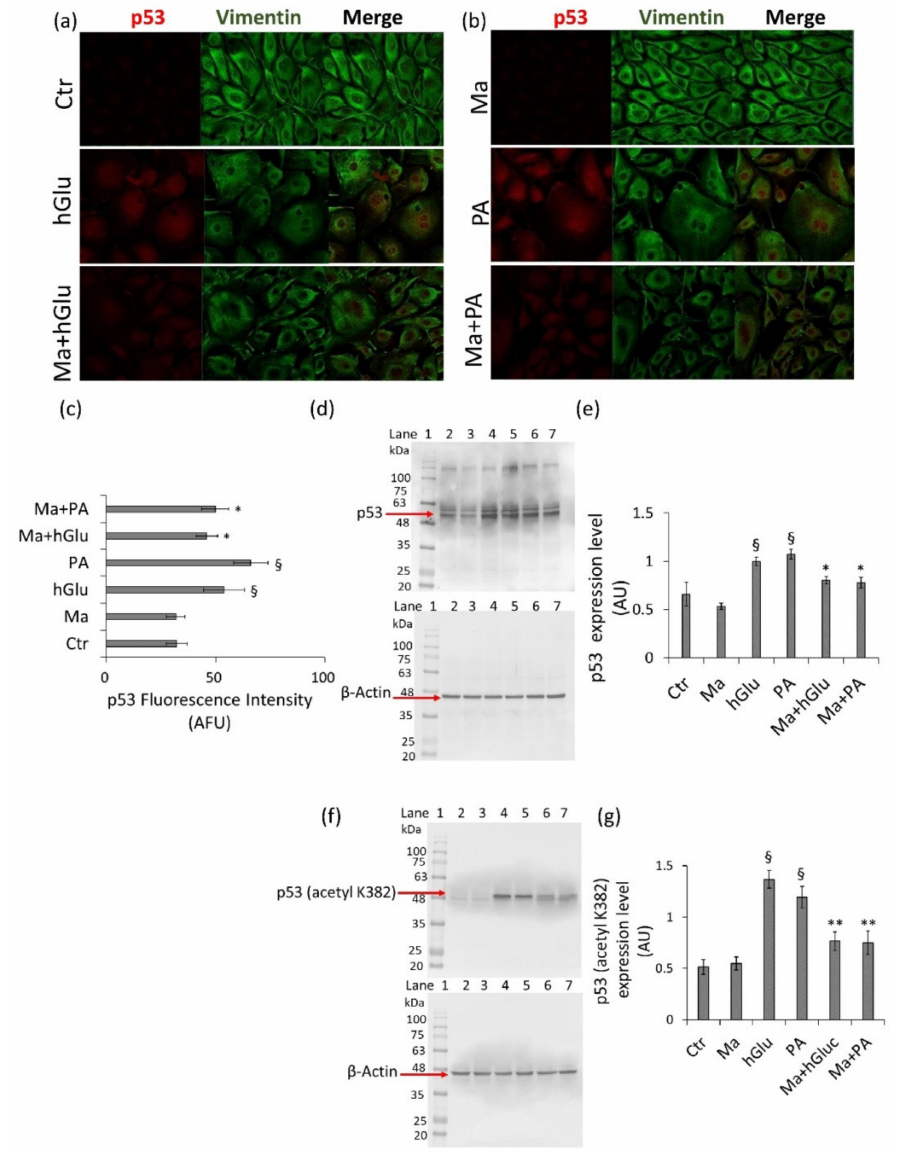
Figure 6. Modulation of p53 by Magliocco. ( a , b ) Representative confocal images of p53 (red) and vimentin (green). ( c ) Fluorescence intensity performed by ImageJ software and expressed as arbitrary fluorescence units (AFU) ± SD of n = 3 replicates. ( d , e ) Western blot analysis of total and ( f , g ) acetylated (acetyl K382) p53 expression levels. Lane 1 = protein ladder molecular weight markers, lane 2 = Ctr, lane 3 = Ma, lane 4 = hGlu, lane 5 = PA, lane 6 = Ma+hGlu, and lane 7 = Ma+PA. The analysis of densitometric intensity was calculated with ImageJ software and expressed as arbitrary units (AU) ± SD of n = 3 replicates. β -Actin was used as the internal control. § p < 0.01 vs. Ctr, * p < 0.05 vs. hGlu or PA, and ** p < 0.01 vs. hGlu or